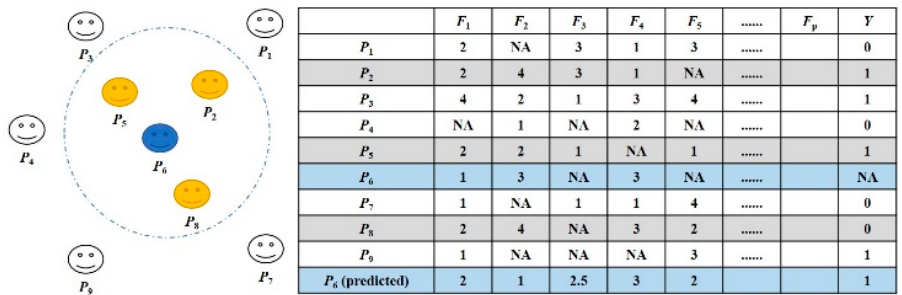
Figure 1. User-based collaborative filtering: ( a ) Conceptual schematic describing the idea of a neighbor for patient P 6 for collaborative filtering of size k = 3. The distance between neighborhoods and patient P 6 is quantified by the cosine distance; ( b ) The predicted recommended outcomes for patient P 6 are aggregate estimates over the three neighborhoods.